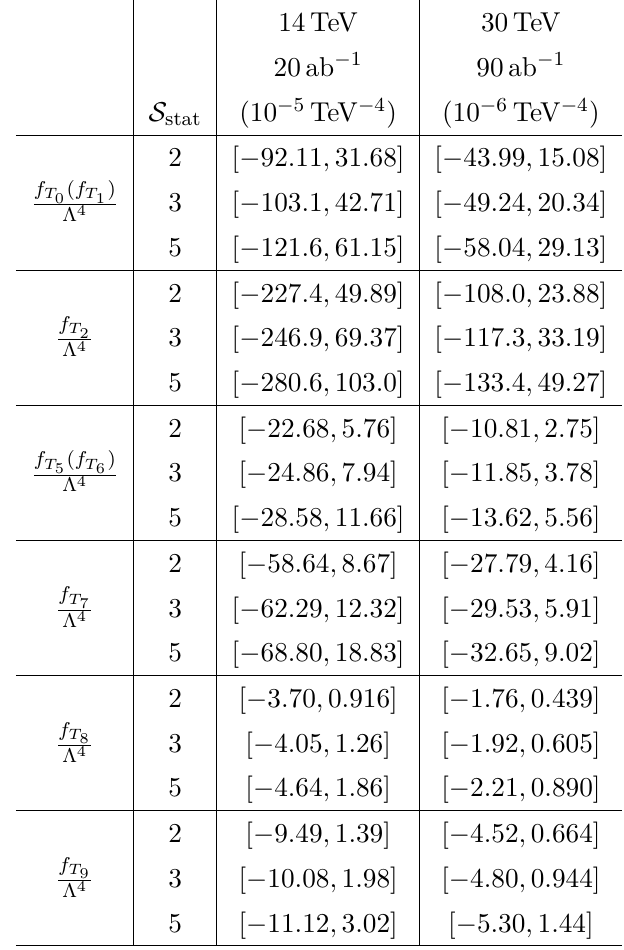
Table 6 . The projected sensitivities on the aQGC coefficients at the muon colliders with different c.m. energies and integrated luminosities for “optimistic”